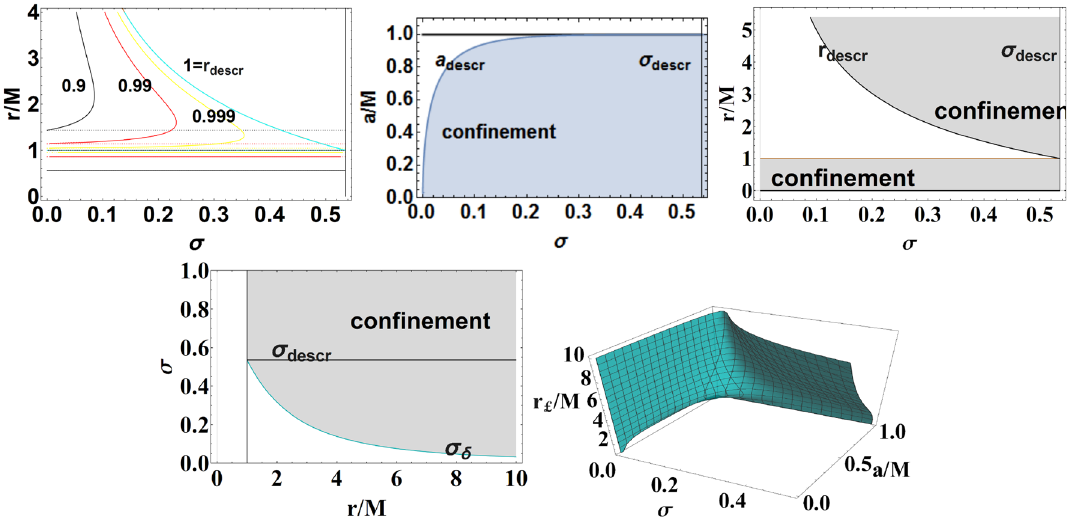
Fig. 13 Inner horizon confinement on the extended plane. Constraints also the inner horizon r − ( a ) . The horizons r ± ( a ) are also showed on the existence of orbits of the exterior region on the extended plane (horizontal lines). The limiting value σ descr ≈ 0 . 53 M . A solution is r > r + with frequencies ω − = ω − clearly the inner horizon r − . The larger is the BH spin, the larger can . See the analysis of Sect. 3 and H be the plane value function σ ≤ σ decr . Shaded regions are confine- Eq. (48). Left panel: orbits r £ solutions of ω − = ω − (photons defined H ment regions. Below: 3D plot is r £ , containing a solution of ω − = ω − by the condition L N = 0) as function of the plane σ ∈ [ 0 , 1 ] for as function of a / M and σ . Quantities are defined in Eqs. (53, 50, different spins a / M . The limiting value a = M , black curve coinci- 51, dent also with r descr (σ) . The solutions of ω − = ω − clearly include H